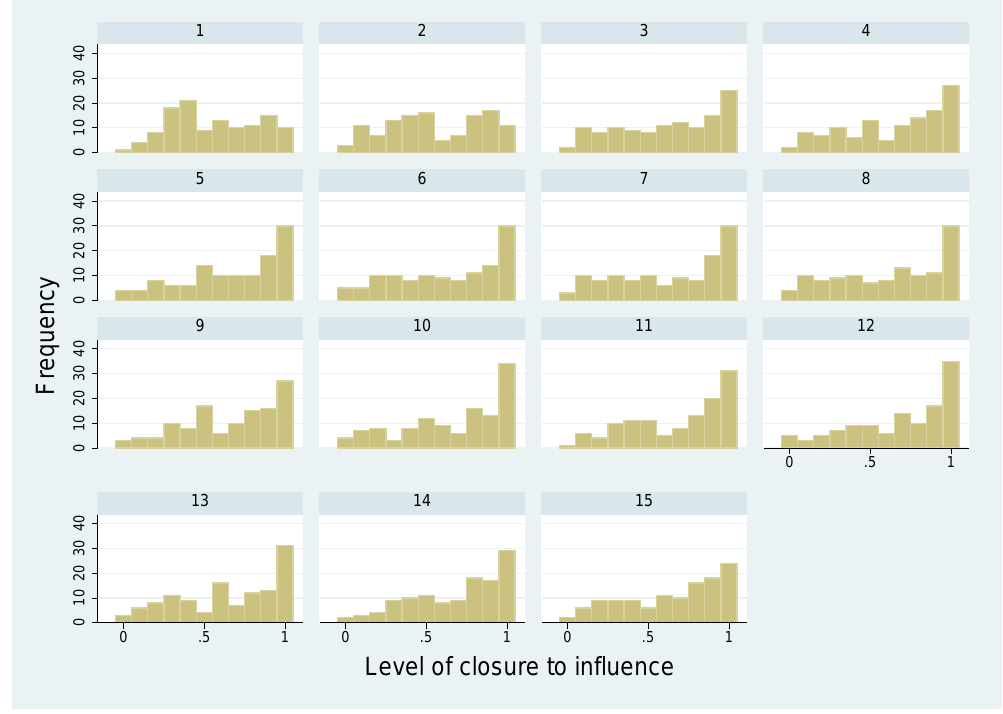
Figure 7: Histograms of the 120 individuals’ levels of closure to influence w indicating the increase in frequency of individual states of complete closure to